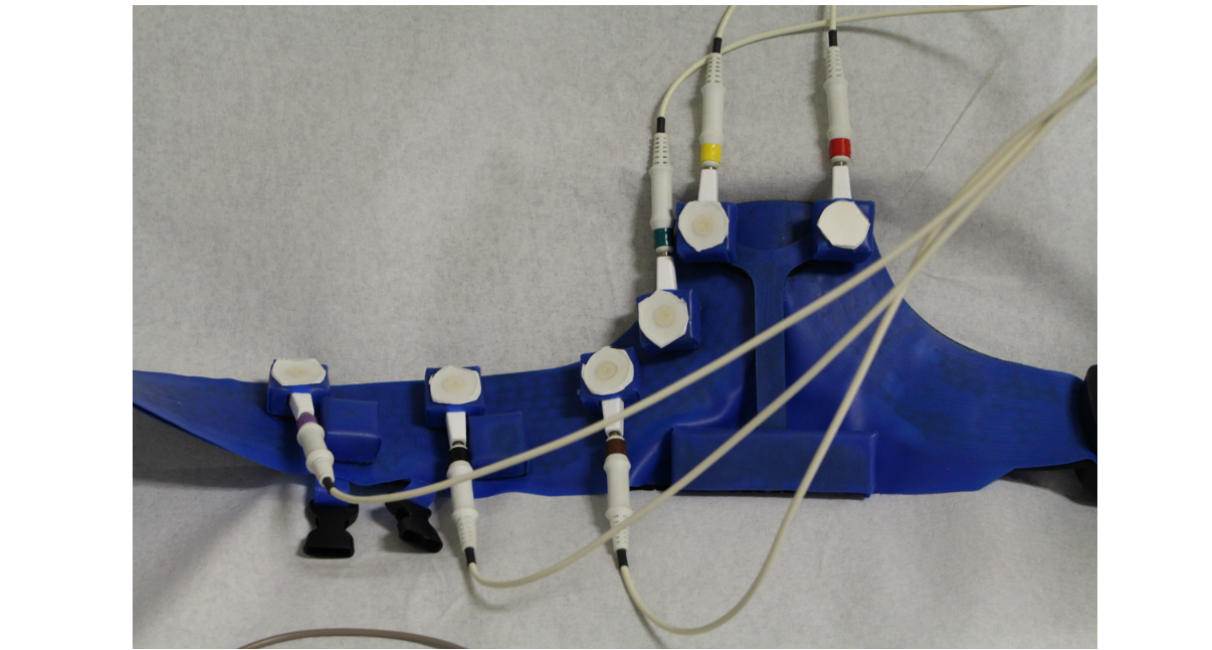
Figure 12. Detailed picture of the prototype (blue) connected to the standard electrocardiogram monitoring equipment. Note that in the final design, the electrode wires will be integrated into the